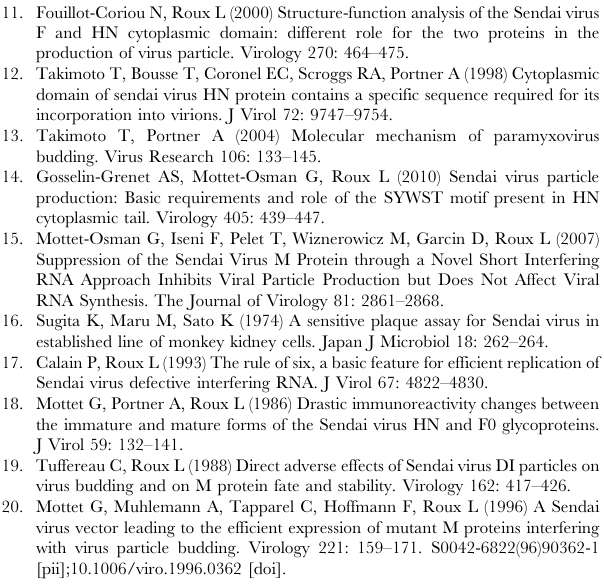
Figure S6 Subcellular localisation of N is not affected by presence or absence of F at the plasma